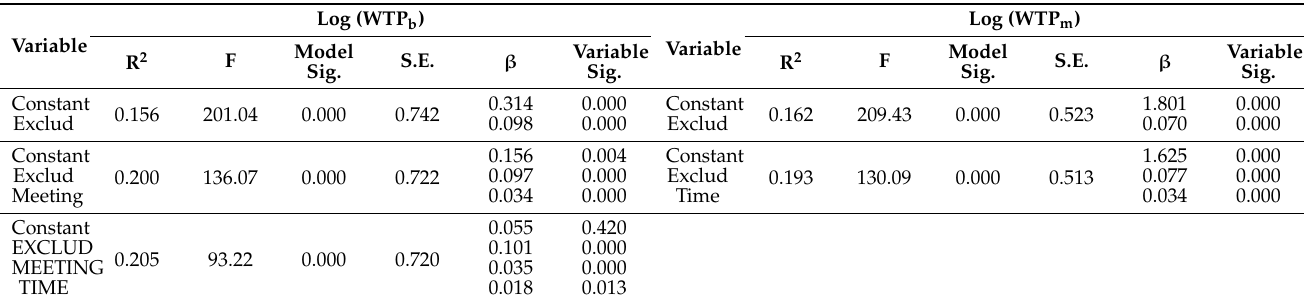
Table 9. Predictive models for log (WTP b ) and log (WTP m